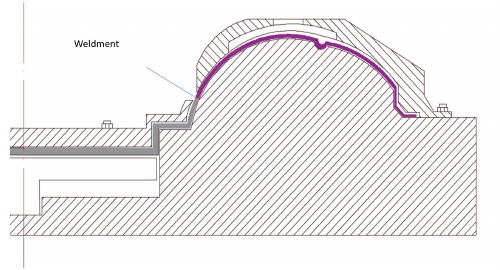
Figure 4. Schematic diagram of welding